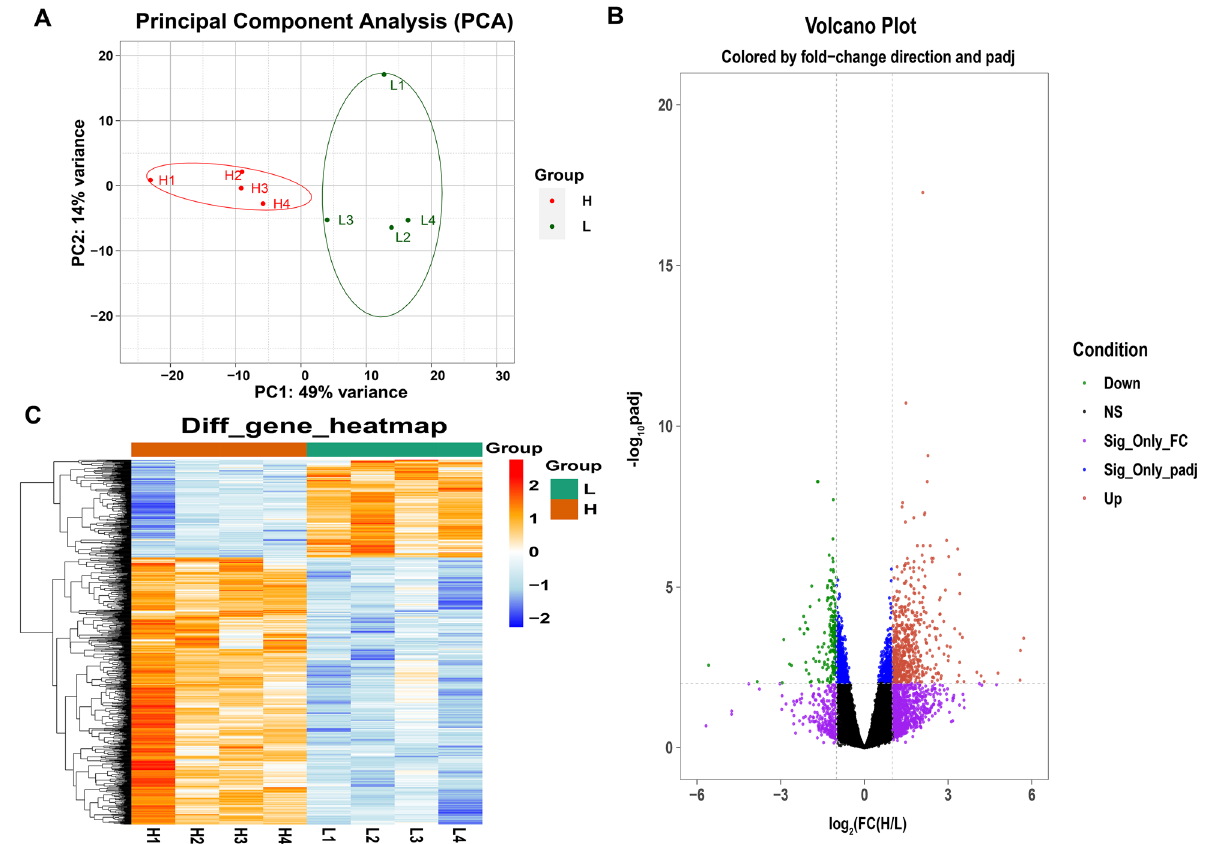
Figure 1. Samples correlation analysis and identification of DEGs between high WHC and low WHC groups. (A) PCA of the identified genes. The red and green dots represent samples of high WHC and low WHC, respectively. (B) Volcano plot for DEGs in LD muscle comparing high WHC group versus low WHC group. The red and green dots represent significant up-regulated (FC ≥ 2 and padj ≤ 0.01) and down-regulated (FC ≤ 0.5 and padj ≤ 0.01) DEGs, respectively. Dots of other colors indicate genes that are not significant. The purple dots denote genes with FC ≥ 2 or FC ≤ 0.5 and padj > 0.01, while the blue dots indicate genes only meet the condition of padj ≤ 0.01. The black dots represent genes with no significant change (0.5 < FC < 2 and padj > 0.01). (C) Heatmap of DEGs. Columns and rows show samples and DEGs, respectively. Red indicates high-level